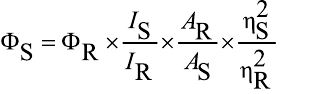
Figure 4. The quantum yields were calculated based on Equa- tion